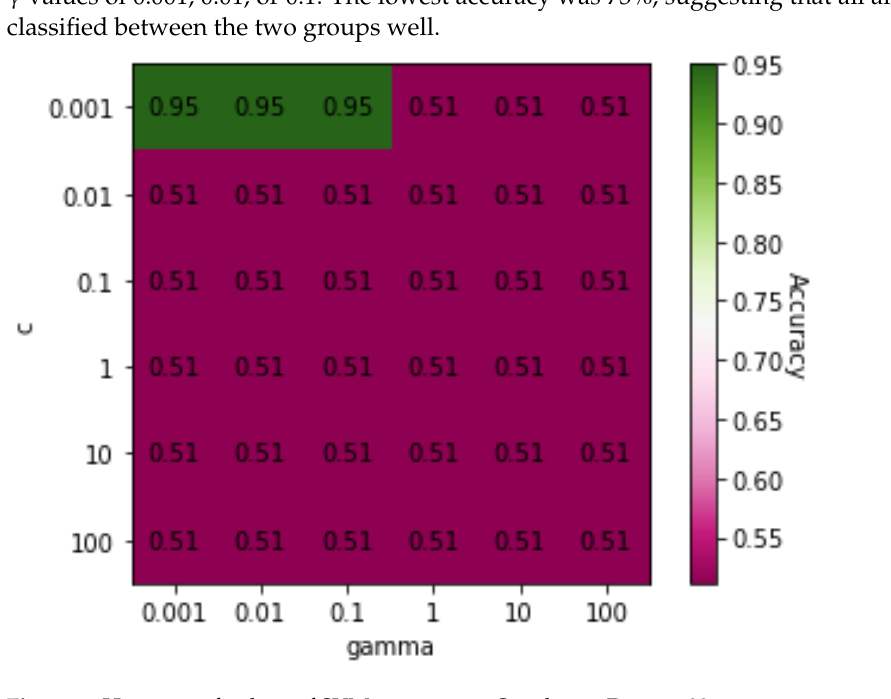
Table 7. Classification results for Dataset 04 (CVD/control).